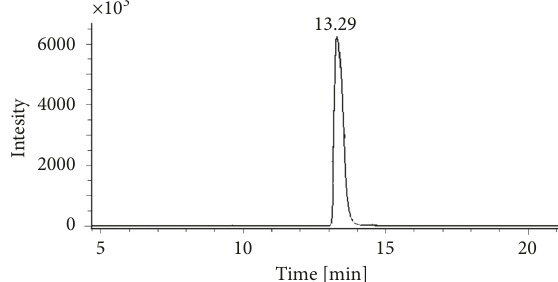
Figure 2: GC spectra of solketal; reproduced from reference